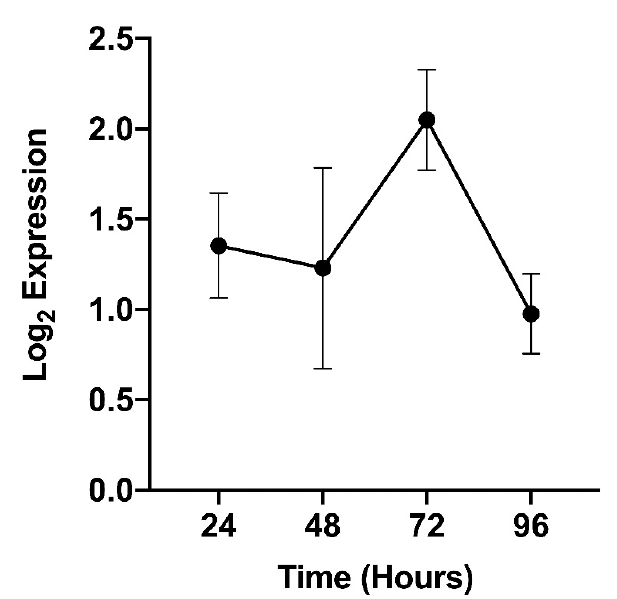
Figure 5. Ae. aegypti cells were infected with DENV-2. At the given timepoints after infection, the cells were lysed and RNA was collected and used to quantify the AAEL002675 gene expression by qRT-PCR. Results are the mean ± standard error of the mean of three independent experiments.